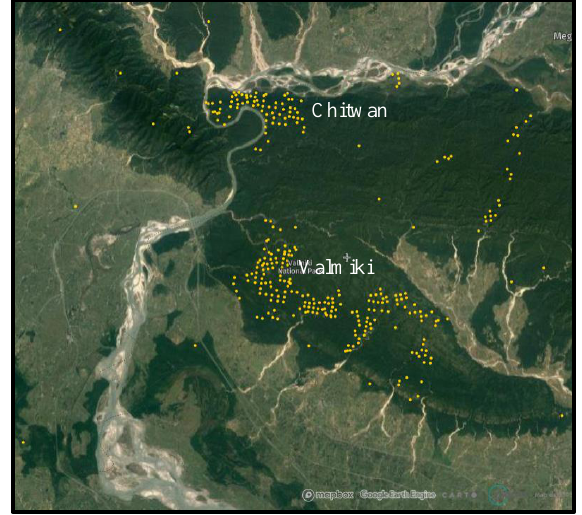
Figure 2 . Detected fires (yellow pixels) on April 12-16, 2021 from VIIRS in the west Chitwan National Park, Nepal and Valmiki National Park, India.